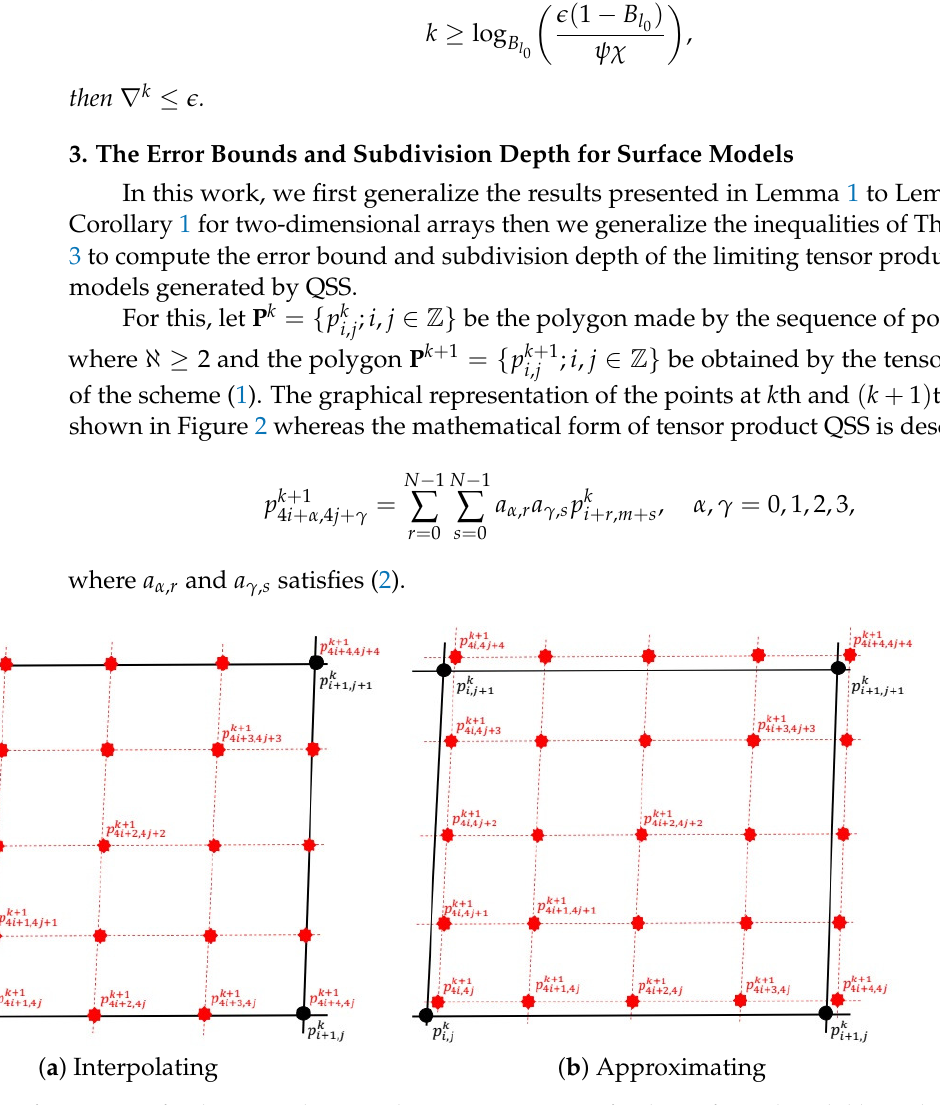
Figure 2. The configuration of new points for the interpolating and approximating QSS for the surface. The solid lines show one face of coarse polygon while the dotted lines show the faces of the refined